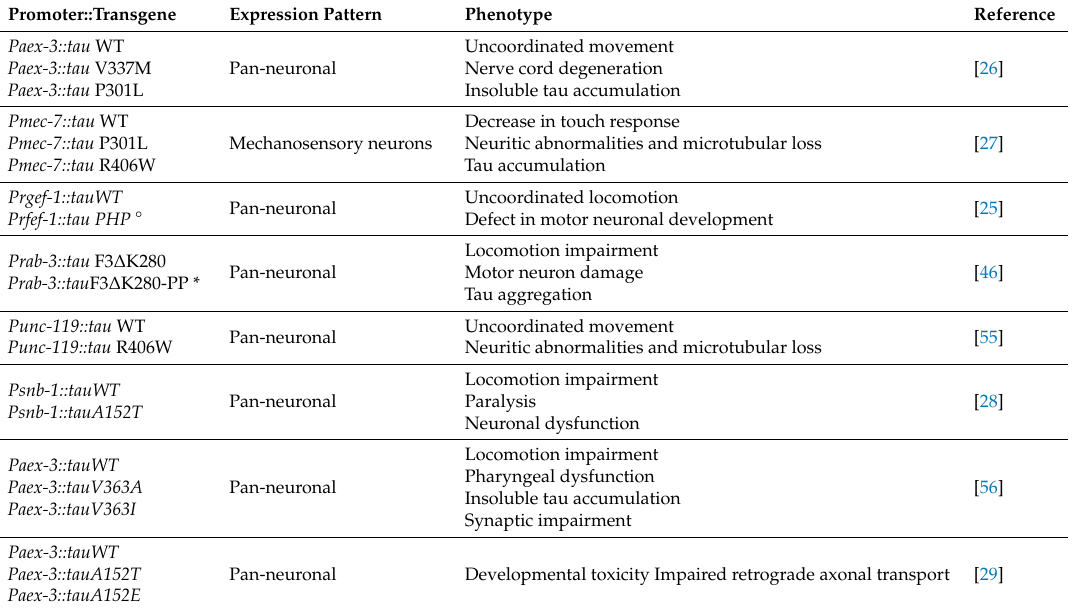
Table 1. Transgenic C. elegans models of tauopathies related to microtubule-associated protein tau ( MAPT) gene